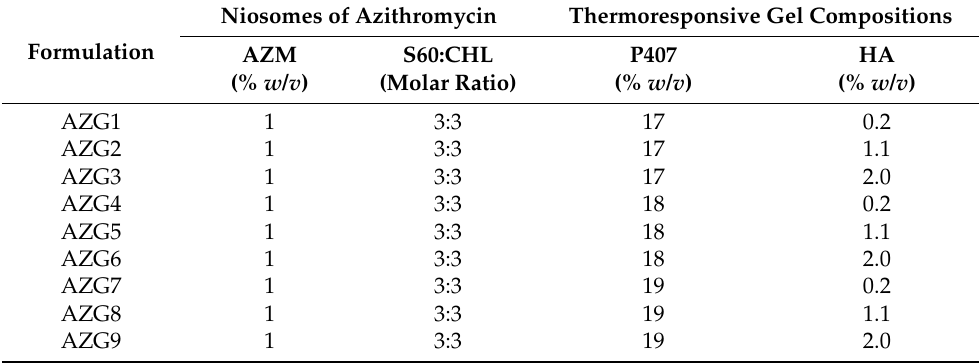
Table 1. Composition of thermoresponsive azithromycin-loaded niosome gels (AZG).